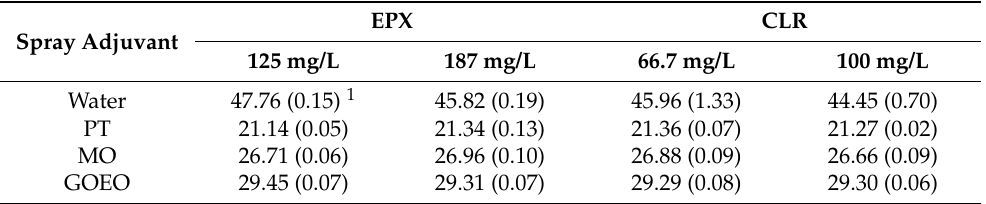
Table 3. Surface tension (mN/m) of EPX and CLR SC with spray adjuvants in different treatment